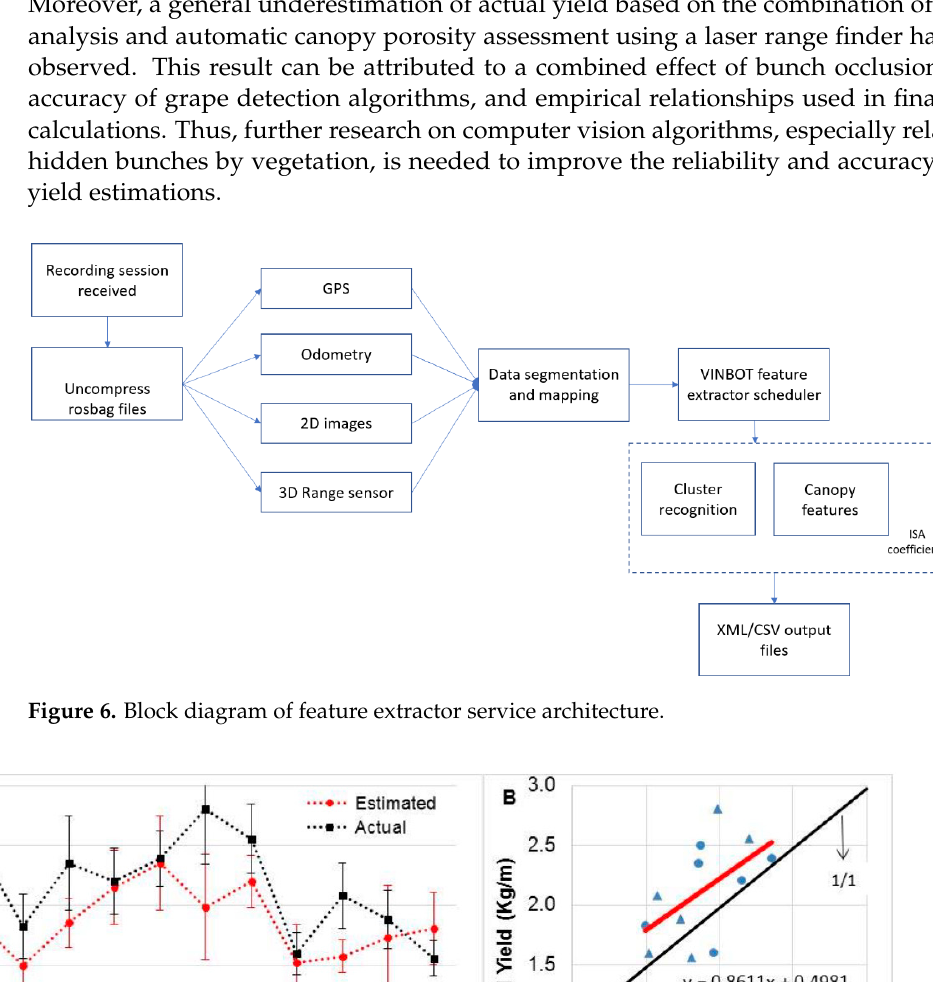
Figure 7. ( A ) Actual vs. estimated values of averaged ( ± standard error) yield per smart point (10 m canopy length); ( B ) relationship between actual and estimated values; ● —‘Alvarinho’; ▲ —‘Arinto’.